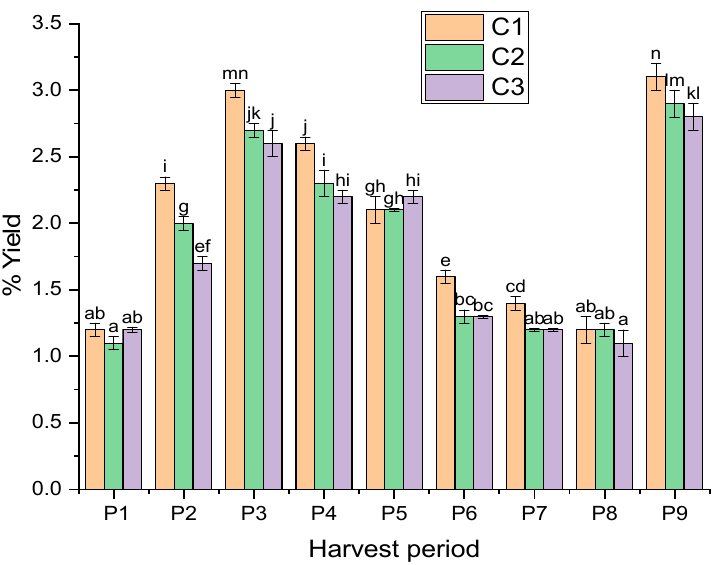
Figure 1. Average yield according to the essential oils from the three cooperatives during nine harvest periods. Each column represented by different letters (a, b, c, d, e, f, g, h, i, j, k, l, m, and n) indicates a significant difference ( p < 0.05) based on Tukey test. Cn: cooperatives, Pn: